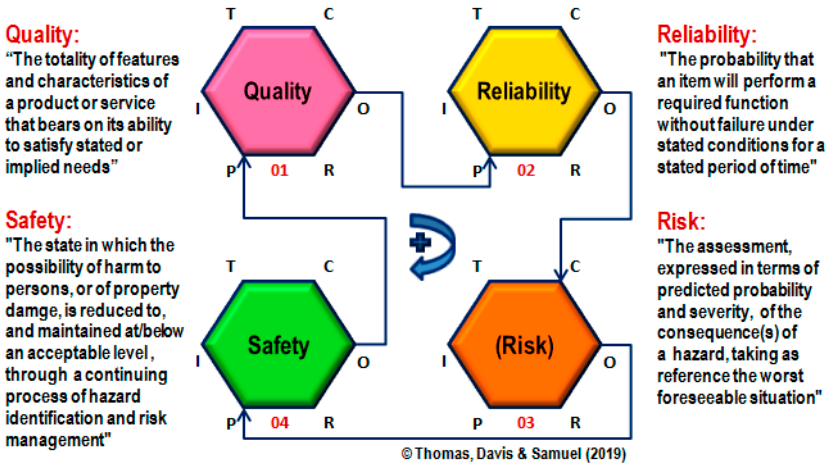
Figure 14. The Quality-Reliability-Risk-Safety Paradigm.